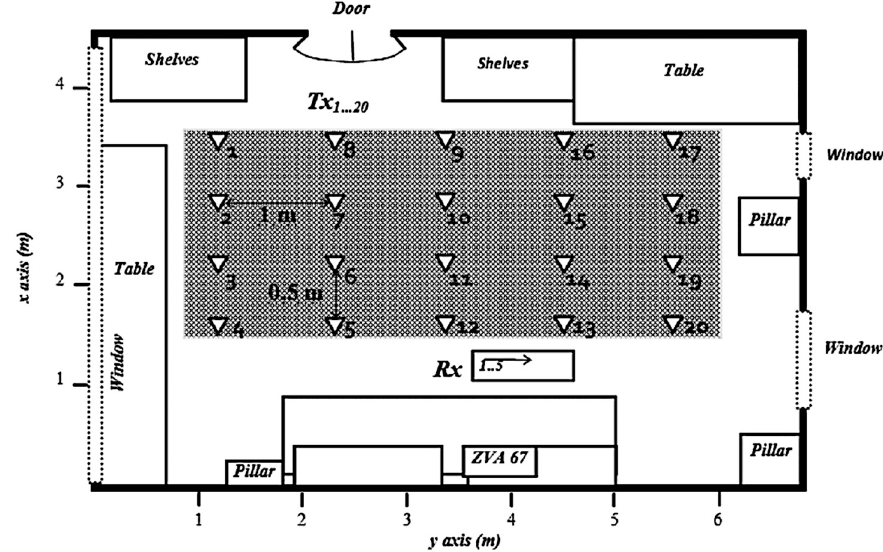
Figure 2. Top view of the electromagnetic characterization laboratory, Polytechnic University of Cartagena (UPCT), Spain. Distribution of measurement points.